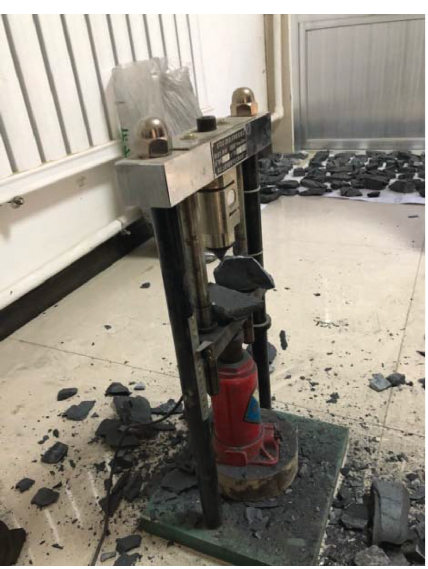
Figure 8: The point load testing machine.